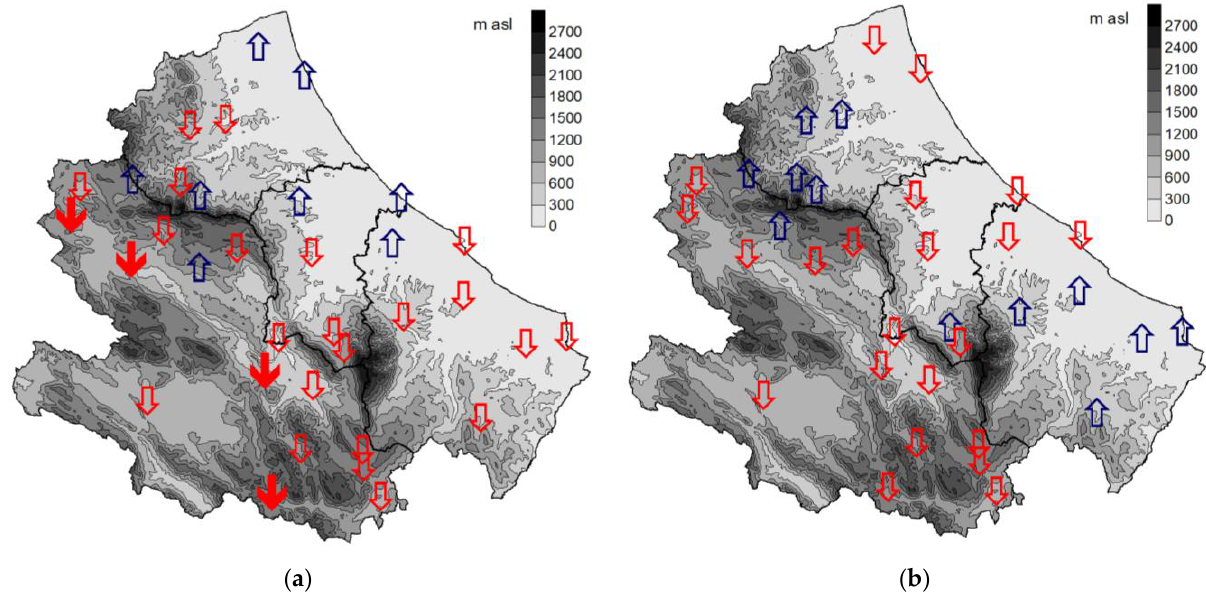
Figure 8. Spatial distribution of trend in PCI series (1980–2018): ( a ) point data; ( b ) grid E-OBS data. Down arrows indicate decreasing trends while upper arrows denote increasing trends. Solid arrows indicate significant trends ( p -Value < 0.10) according to Mann–Kendall test.